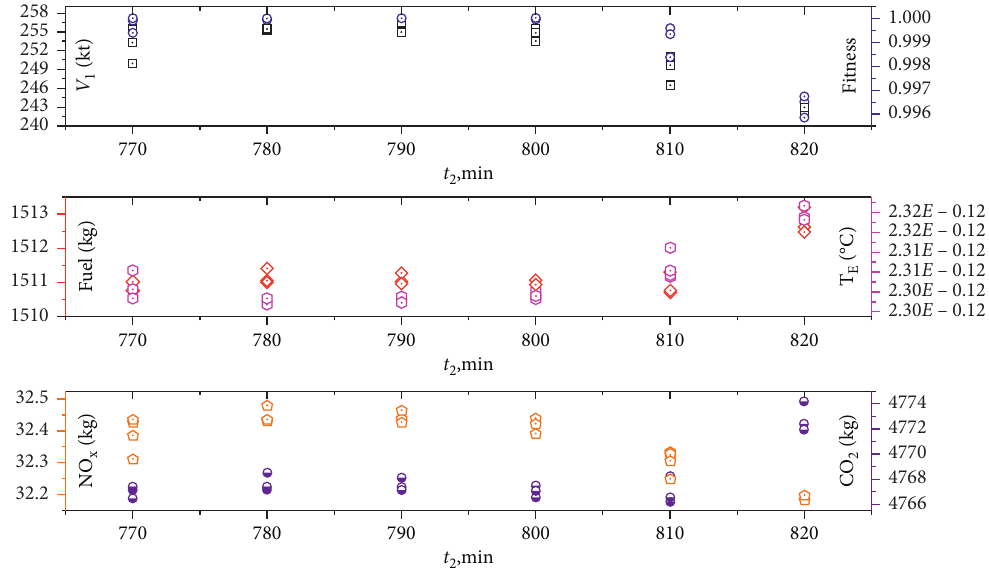
Figure 11: The influence trend of t